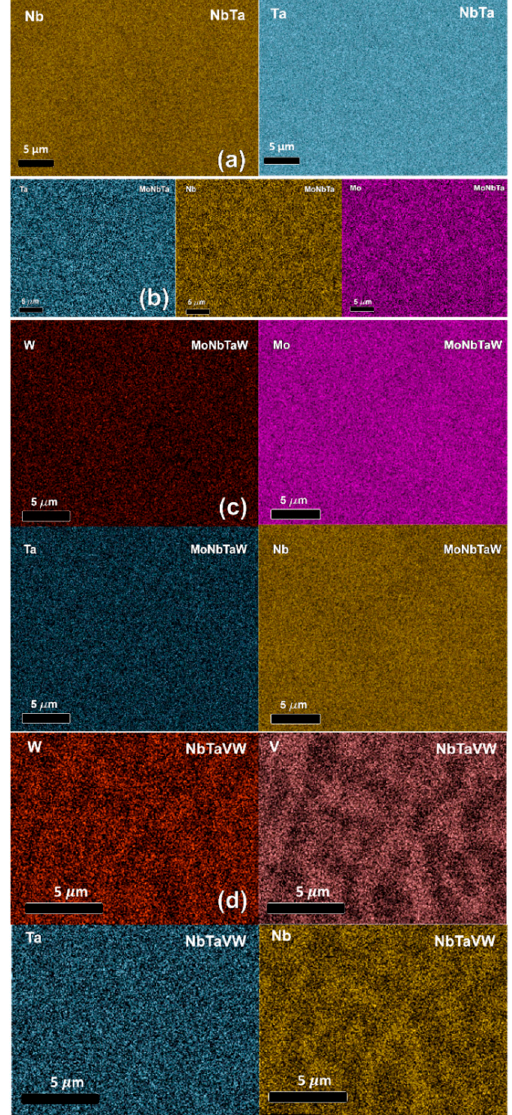
Figure 1. ( a – d ) SEM-EDS of AM refractory alloys, as indicated, showing appreciable elemental segregation only in the NbTaVW RHEA.